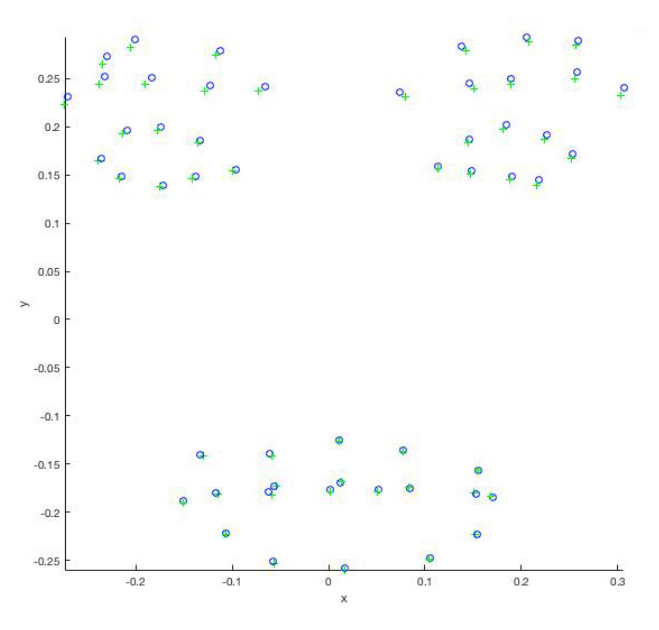
Fig. 8. Points selected for the tests, totaling 52 facial markers.